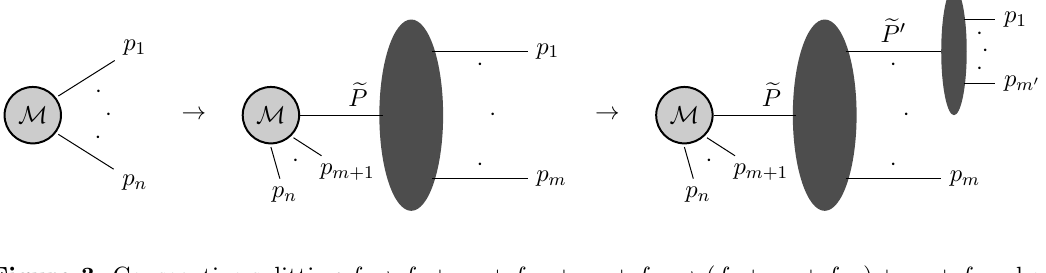
Figure 3 . Consecutive splitting f → f 1 + . . . + f m ′ + . . . + f m → ( f 1 + . . . + f m ′ ) + . . . + f m where an m ′ -parton subset becomes collinear to the direction P ′ within the larger m -parton collinear e